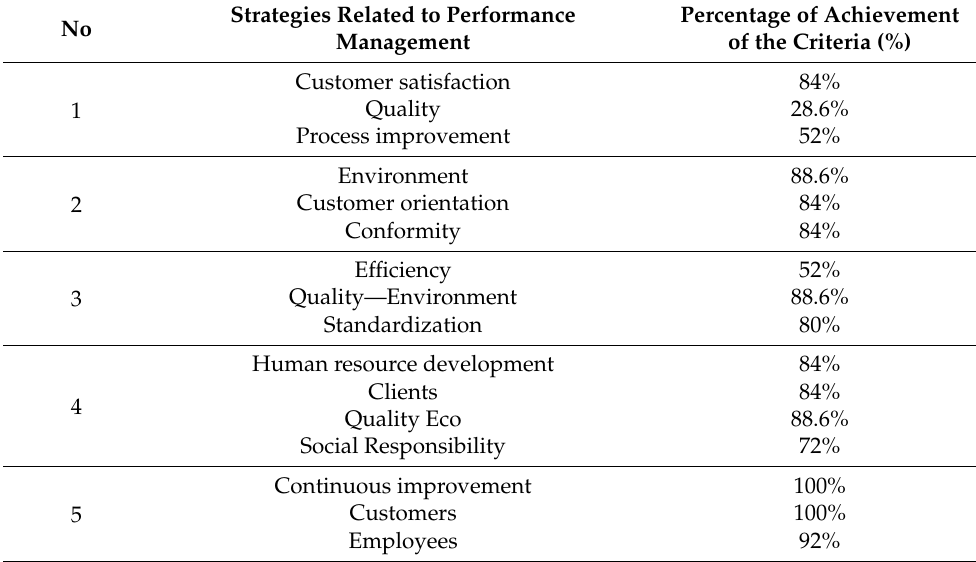
Table 8. Percentage of achievement for the declared